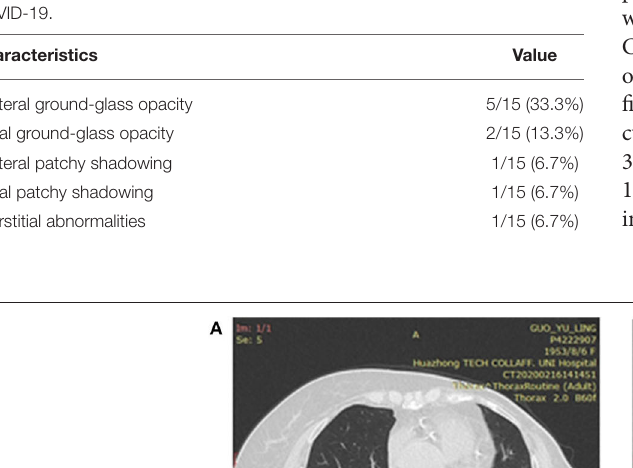
Characteristics and Outcomes; COVID-19; Breast Cancer; Non-cancer; Comparison